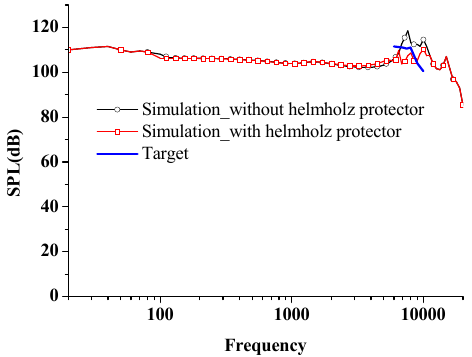
Figure 21. Simulation result (with/without Helmholtz protector).